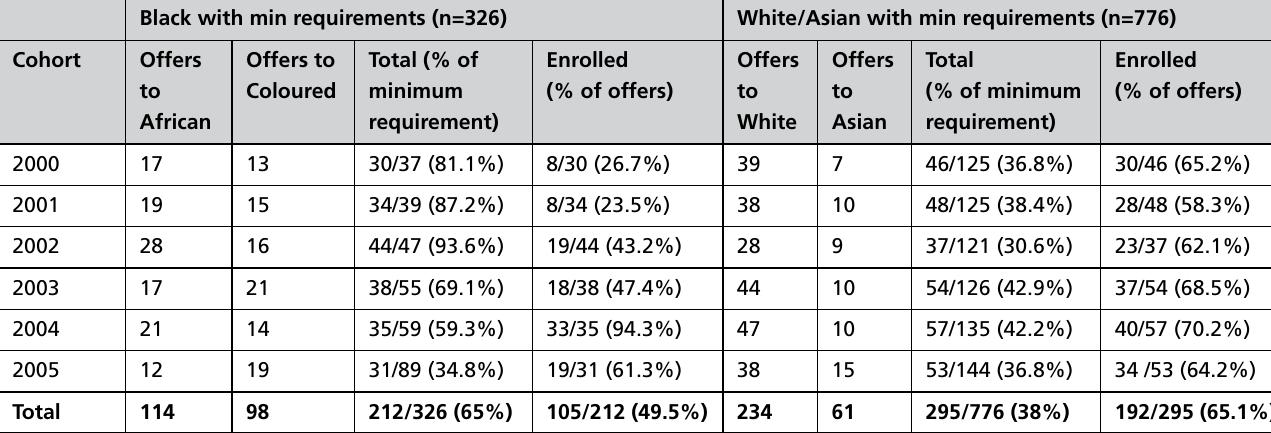
Table 3: Racial profile of applicants who enrolled in the program (n=1102) Black with min requirements (n=326)